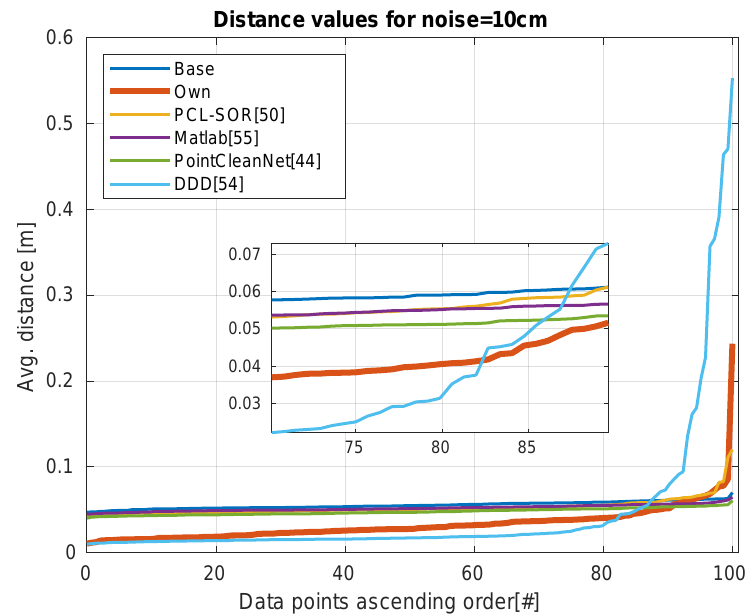
Figure 11. Noise level is 10 cm. The distribution of errors over the